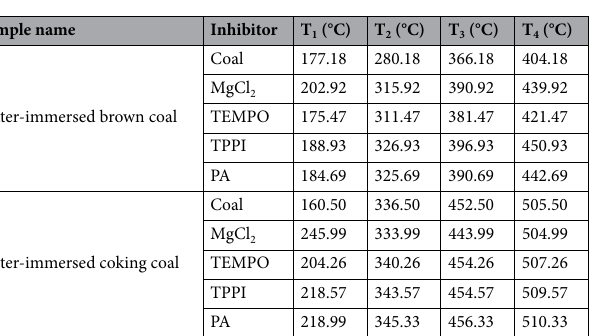
Table 5. Characteristic temperature of water-immersed brown coal and coking coal after adding